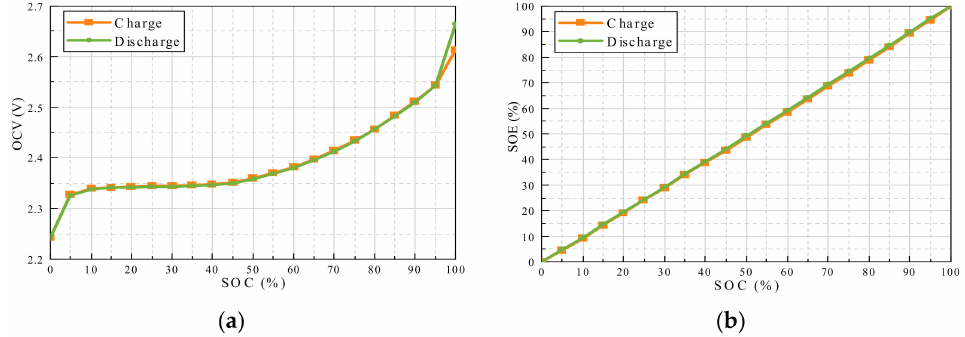
Figure 3. The curve of ( a ) State of Charge (SOC)–open circuit voltage (OCV) and ( b ) SOC–state of energy